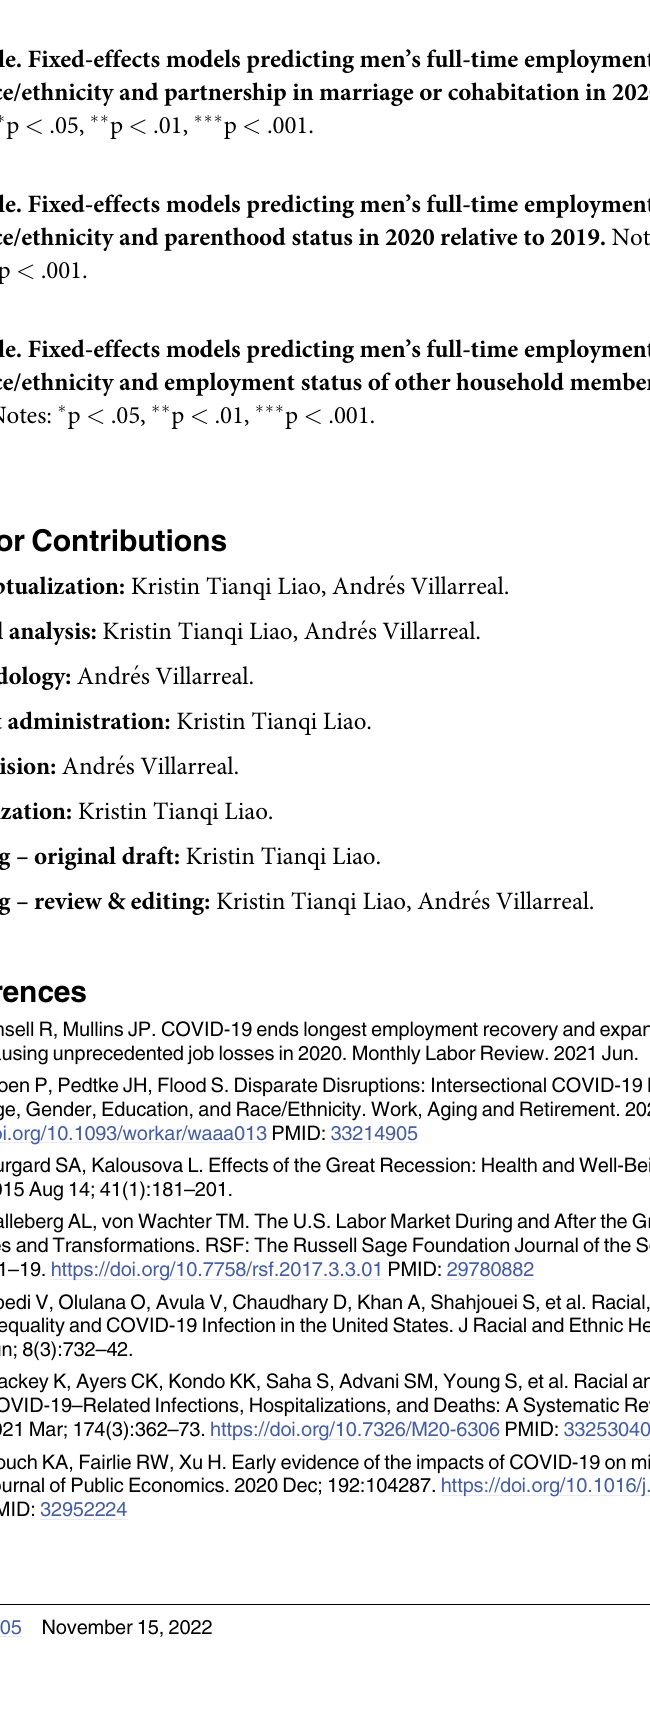
S2 Table. Fixed-effects models predicting hours worked at main job by immigrant status